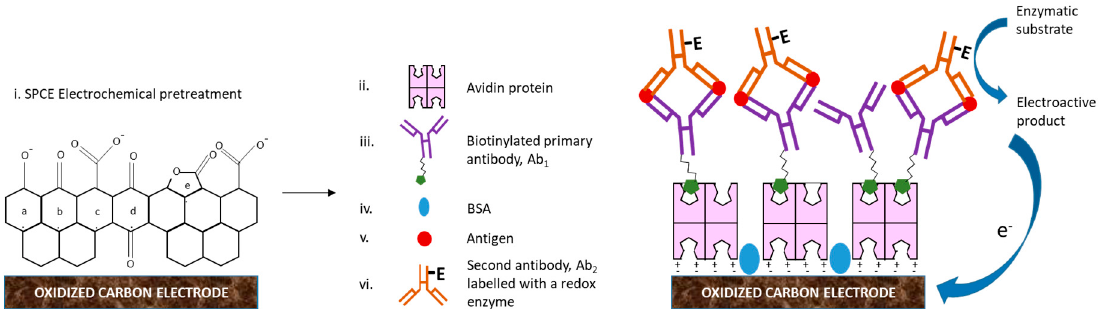
Figure 6. Fabrication steps of an EI based on neutravidin-coated SPCE surface in order to avoid NSB of immunoreagents. i). Pretreatment of a SPCE surface produce several functional groups: a. phenols, b. carbonyls, c. carboxyls, d. quinones and e. lactones. These functional groups in aqueous solutions